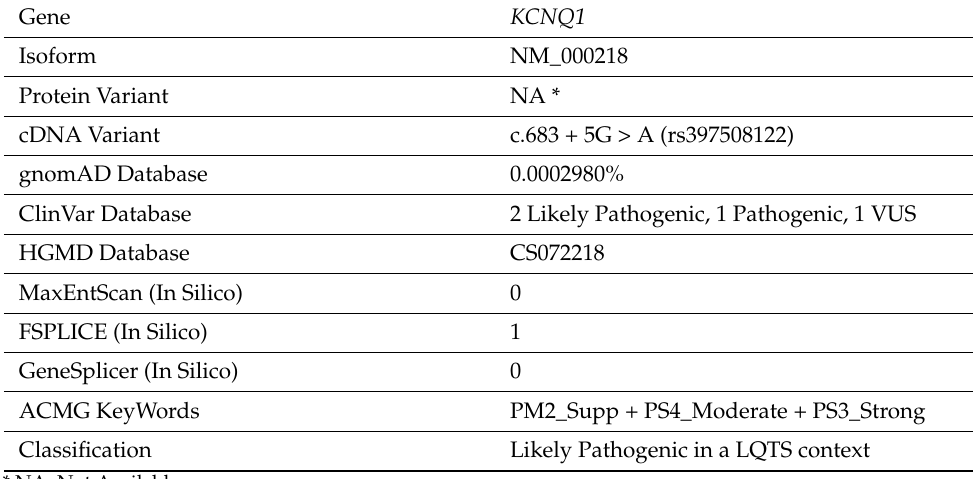
Table 1. Report of rare genetic mutation identified in the index